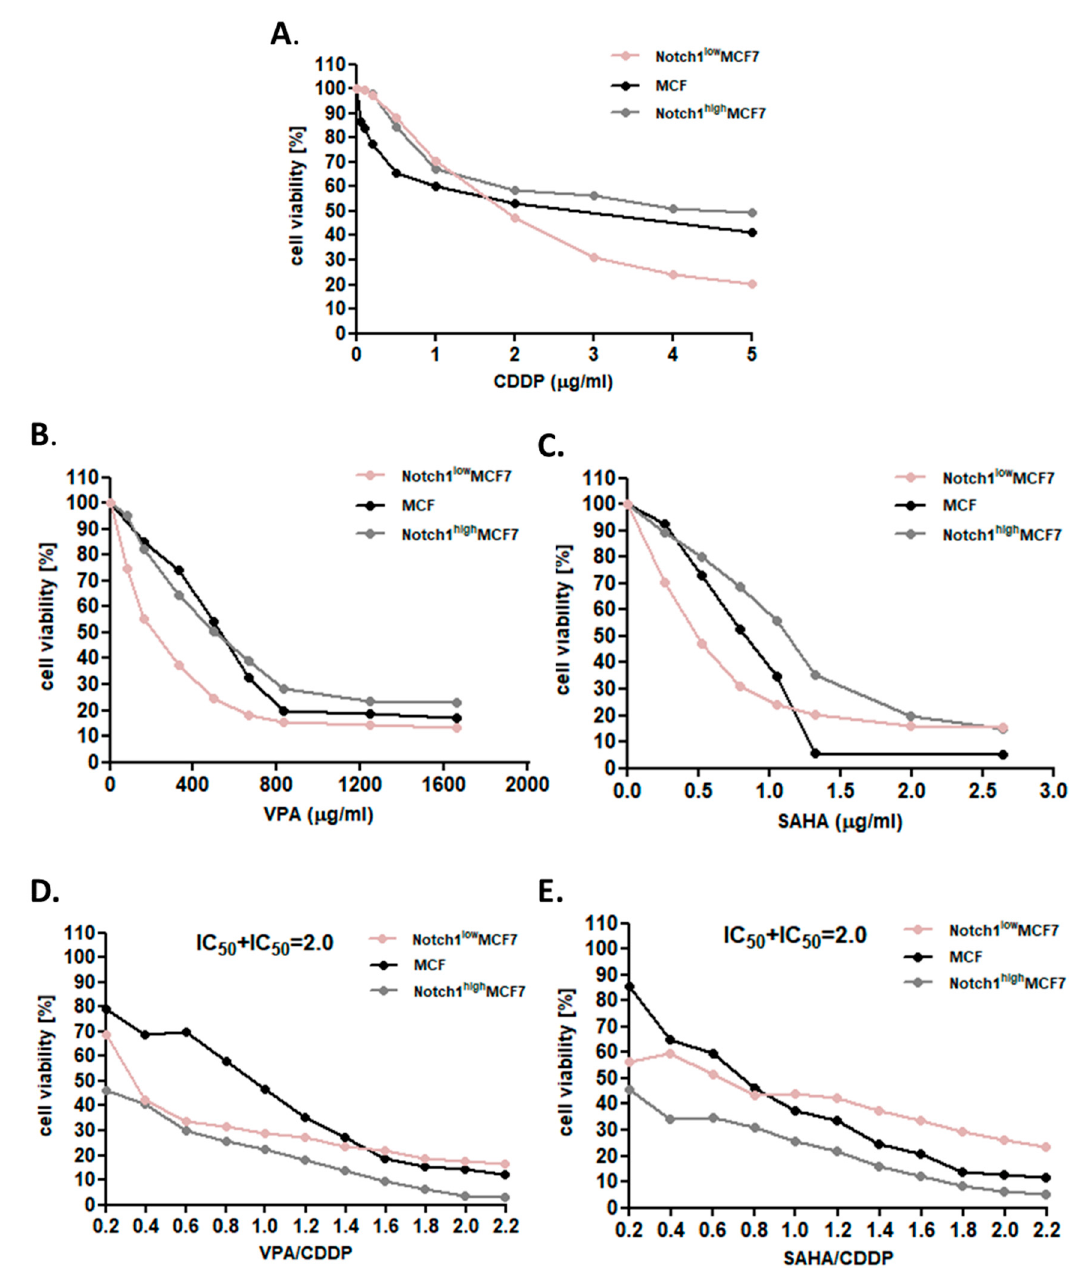
Figure 1. The anti-proliferative effects of CDDP, VPA, or SAHA in MCF7 cells. ( A ) The anti-proliferative effect of CDDP in MCF7 [22], Notch1 low MCF7, and Notch1 high MCF7 cells; ( B ) the anti-proliferative effect of VPA in MCF7 [22], Notch1 low MCF7, and Notch1 high MCF7 cells; ( C ) the anti-proliferative effect of SAHA in MCF7 [22], Notch1 low MCF7, and Notch1 high MCF7 cells; ( D ) the anti-proliferative effect of combined treatment of VPA and CDDP in MCF7 [22], Notch1 low MCF7, and Notch1 high MCF7 cells; ( E ) the anti-proliferative effect of combined treatment of SAHA and CDDP in MCF7, Notch1 low MCF7, and Notch1 high MCF7 BC cells. Transformed and native MCF7 cells were exposed to concomitant HDIs’ and CDDP treatment using different ratios of the IC 50 (2.0 = IC 50 + IC 50 ). The cell viability was measured by the MTT assay. The results are presented from three independent experiments ( n =